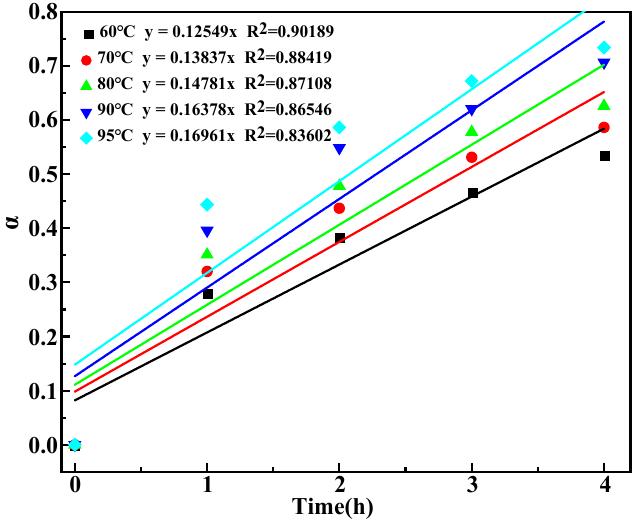
Figure 6. Plots of α versus time at different temperatures.